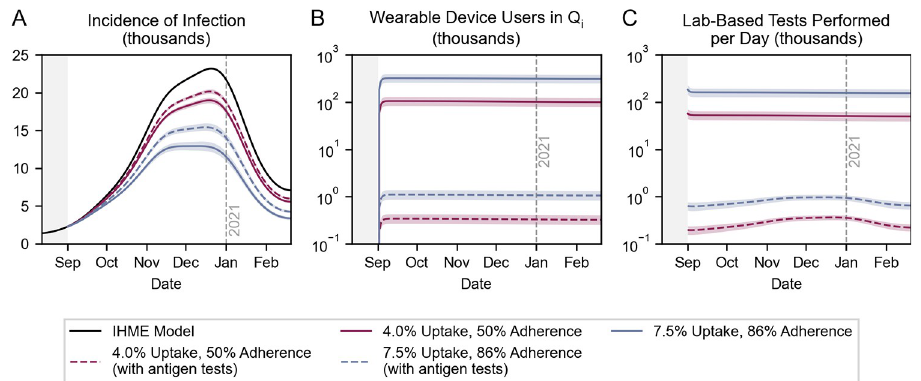
Fig 6. Wearable sensor deployment with confirmatory rapid antigen tests. Time series depiction of (A) the incidence of infection, (B) the number of wearable device users incorrectly in quarantine, and (C) the daily demand for lab-based tests. Detection sensitivity and specificity are set to their nominal values of 80% and 92%, respectively.